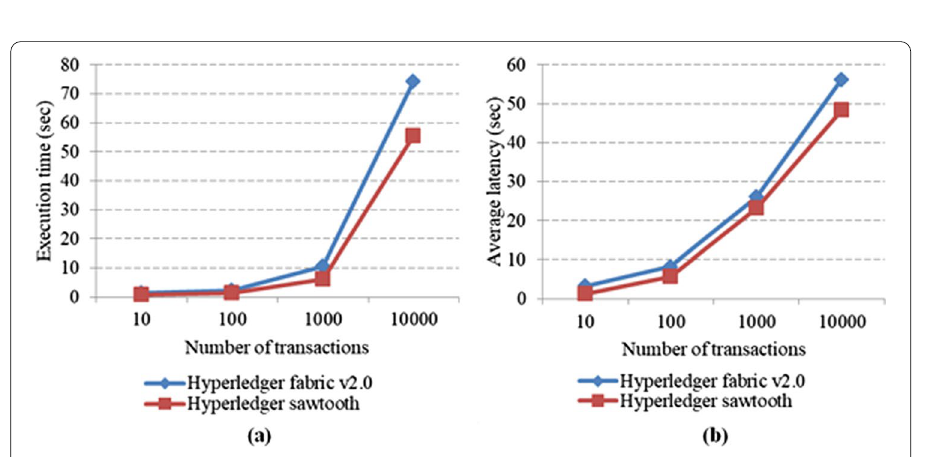
Fig. 8 Blockchain performance for initialization process: a execution time and b average latency. Performance of blockchain that is third phase of the system is presented in graphical form for initialization process execution. Initialization process is an operation executed by node when nodes needs to add new block created from the signature. a Execution time required for initialization process using Hyperledger fabric 2.0 and sawtooth is represented. b Average latency required for initialization process execution on system when implemented using Hyperledger v2.0 and sawtooth is graphically